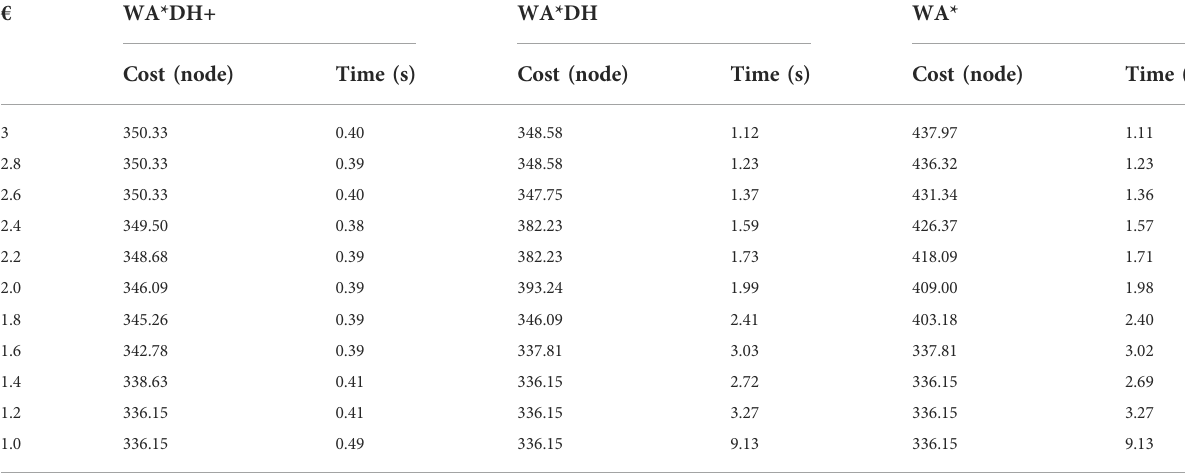
TABLE 5 Quantitative comparison of the performances of algorithms on simulation